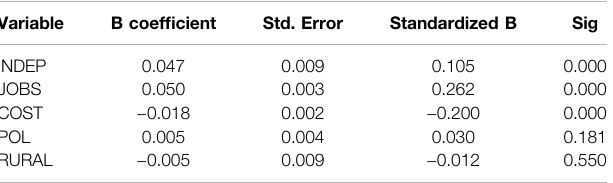
TABLE 6 | Main utility model (medium and long term). TABLE 7 | Short-term utility